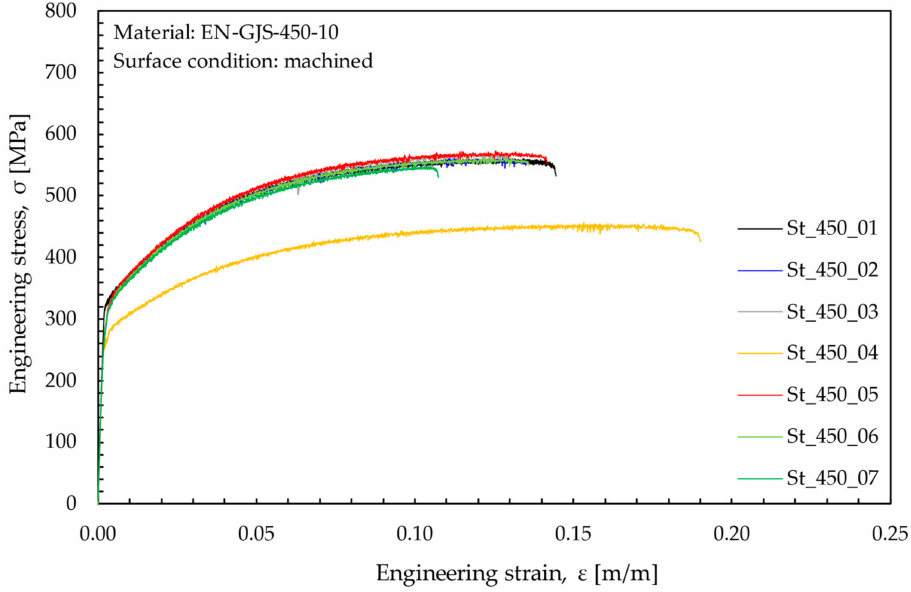
Figure 8. Static engineering stress-strain curves for